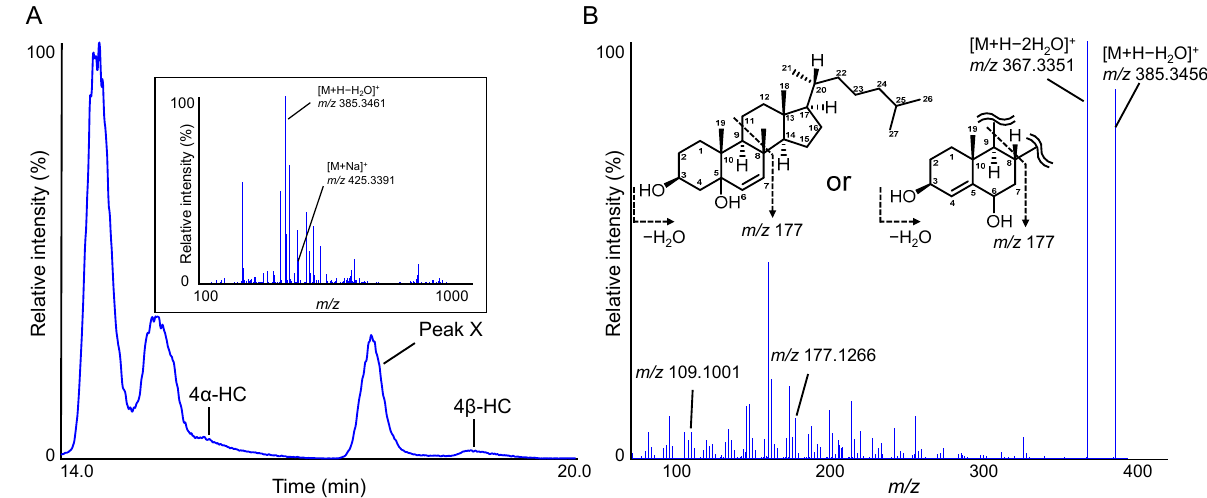
Figure 2. Typical Q1 chromatogram and MS spectrum of peak X ( A ); product ion spectrum of peak X ( B ). An extended Q1 chromatogram between the retention times of 14.0–20.0 min is shown. K2-EDTA plasma collected from healthy volunteers, stored at − 20 °C for 13 months in the dark, was analyzed by LC-HRMS. Details of this process are shown in the Methods section. The sample was saponified, extracted with hexane, and analyzed using LC-HRMS. Refer to the Methods section for details regarding the conditions.